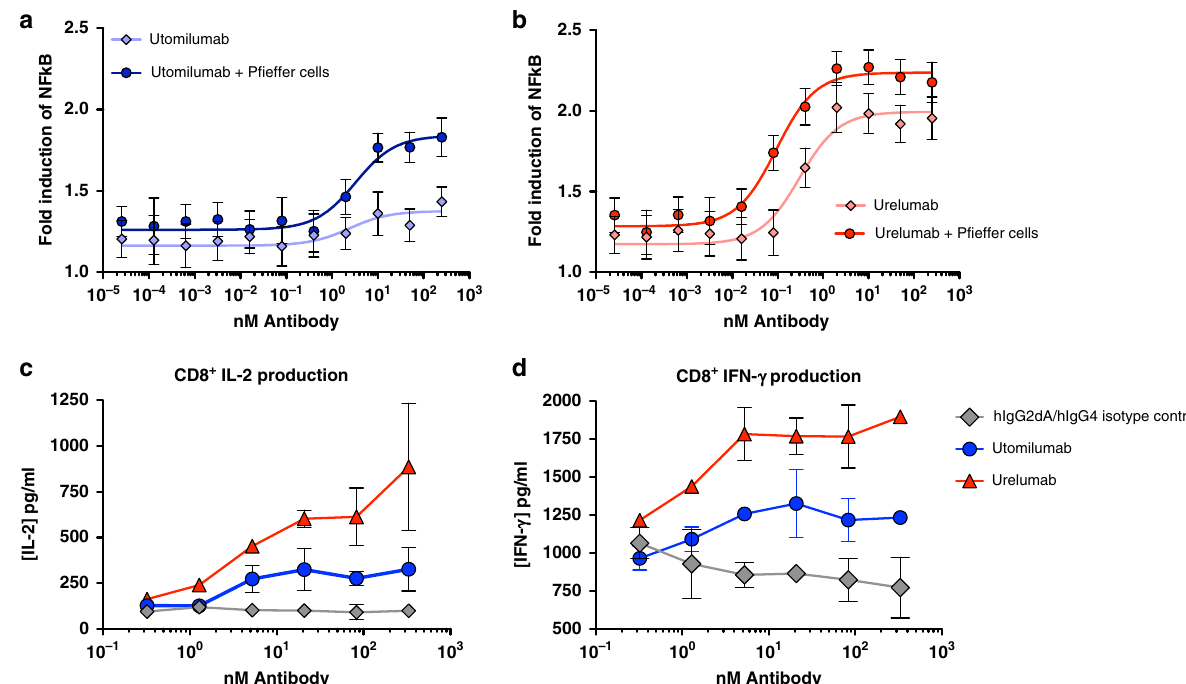
Fig. 7 Urelumab activates 4-1BB signaling more strongly than utomilumab. Human 4-1BB NF- ĸ B luciferase reporter HEK293 cells were incubated with fi vefold increasing concentrations (max 250 nM) of a utomilumab or b urelumab antibody at 37 °C for 6 h before measuring luciferase activity and comparing to unstimulated cells. Mean fold induction was plotted against concentrations of test antibodies. Error bars represent the propagated standard deviation (SD) of three measurements. Solid lines are fi ts with dose-response curves with maximal fold induction of 1.38 ± 0.051 and 1.84 ± 0.053 for utomilumab and 1.99 ± 0.046 and 2.24 ± 0.033. c , d Puri fi ed human CD8 T cells were stimulated with plate bound anti-CD3 (50 ng/ml) plus each plate bound antibody with fourfold increasing concentrations (max 333.33 nM) at 37° C for 72 h and human cytokine production was measured by ELISA. Error bars represent the standard deviation of two measurements. All cytokines are measured from the same